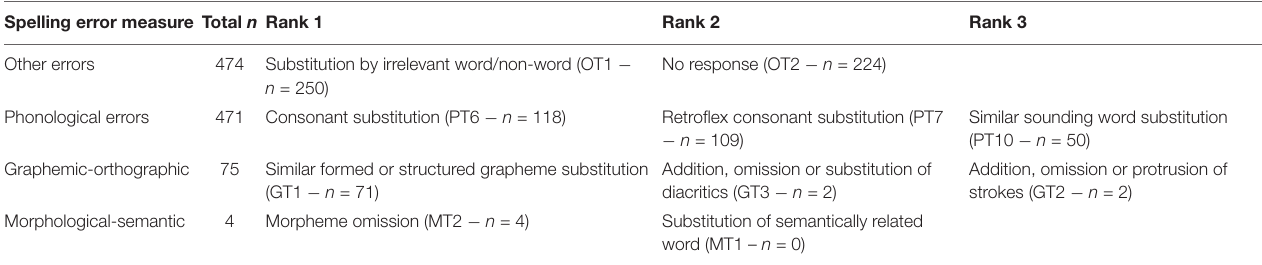
TABLE 7c | Most frequently occurring subtypes of spelling errors within triple-code categories for